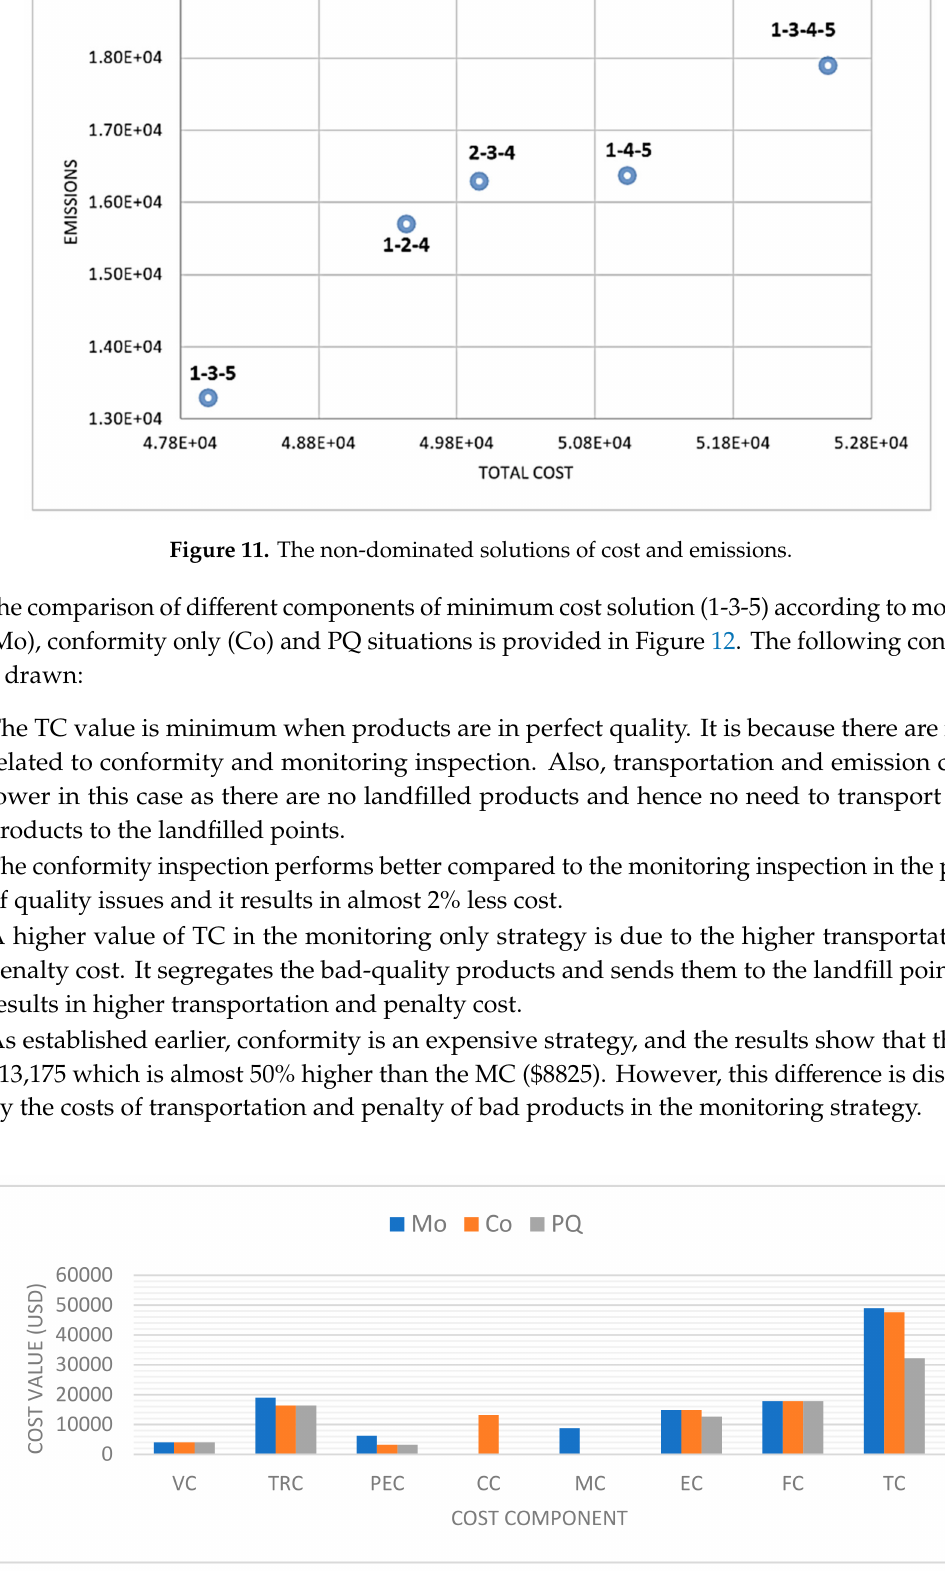
Figure 12. Cost comparison of monitoring only (Mo), conformity only (Co) and perfect-quality products